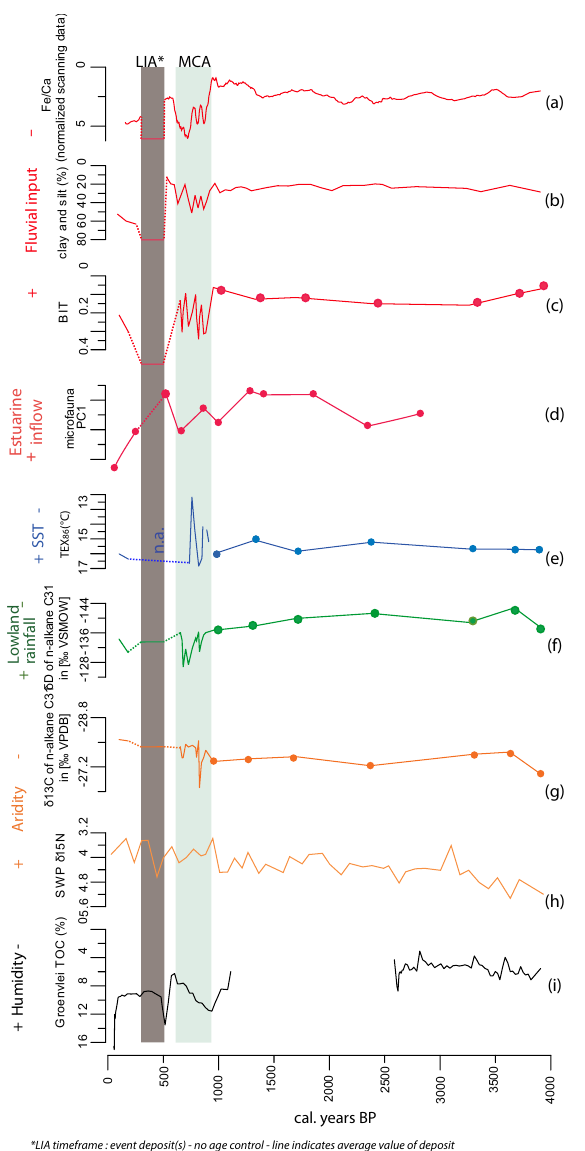
Figure 4. Organic and inorganic down-core geochemistry of GeoB18308-1 (a–g) as indicators for fluvial input, SST, SRZ and aridity. Low-resolution records are marked by colored dots. SSTs for samples with BIT above 0.3 were not calculated. The indicator of estuarian inflow is deduced from factor loadings along axes 1 of a PCA on microfossil distribution of core samples. For comparative purposes regional paleoenvironmental records are plotted: (h) arid- ity index from Seweweekspoort (Chase et al., 2013) and (i) indirect humidity index from Groenvlei (Wündsch et al., 2016).